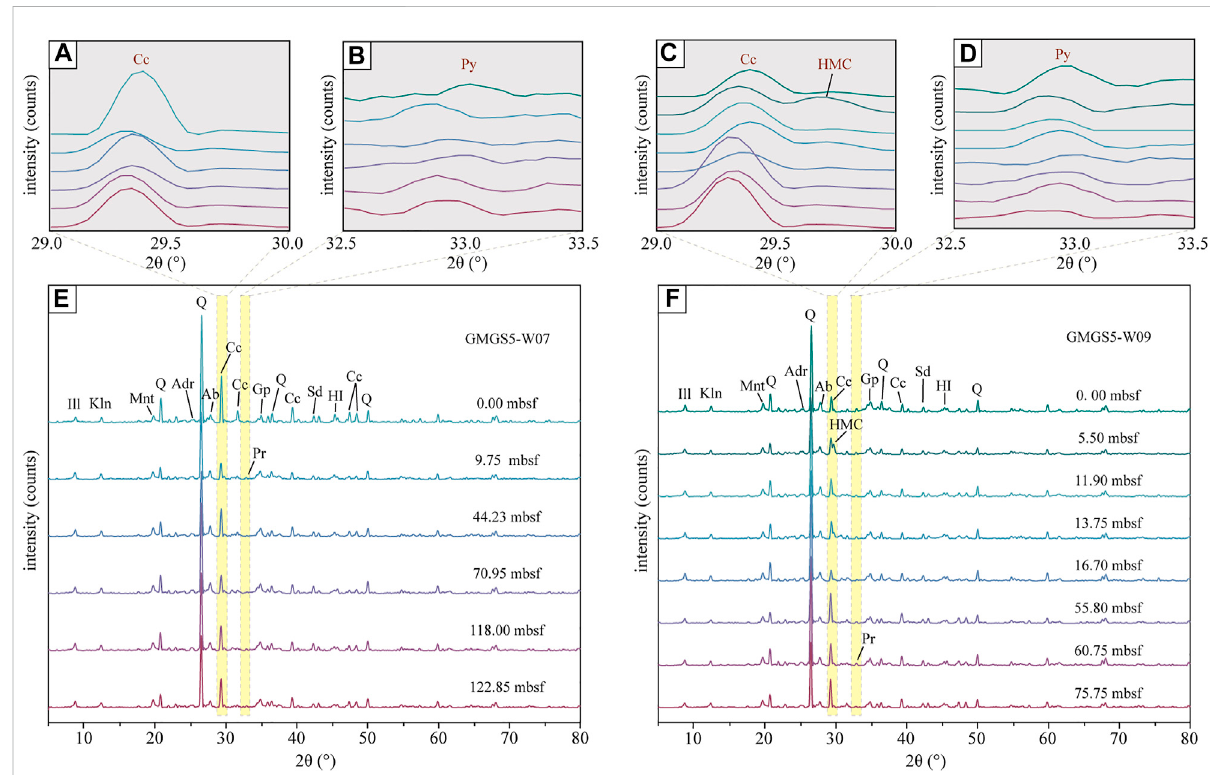
FIGURE 3 X-ray diffractionresults atsiteW07 (E) andW09 (F) . (A,C) and (B,D) werezoomedby29.0 ° < 2 θ < 30.0 ° and22.5 ° < 2 θ < 33.5 ° ,respectively. Ill:Illite; Kln: Kaolinite; Mnt: Montmorillonite; Q: Quartz; Ab: Albite; Cc: Calcite; Sd: siderite; HMC: high-Mg calcite; Adr: Anhydrite; Gp: Gypsum; and Hl: